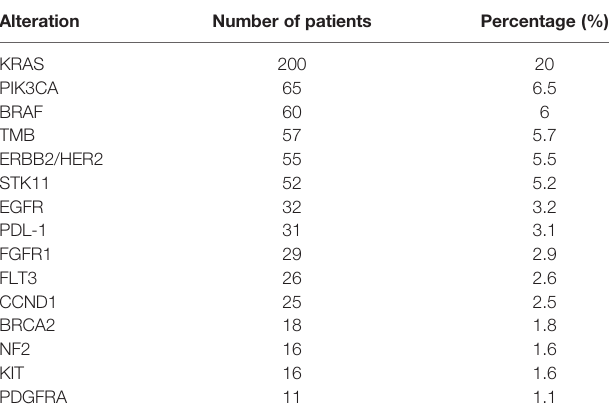
TABLE 4 | Prevalence of actionable alterations among 1,000 patients studied.